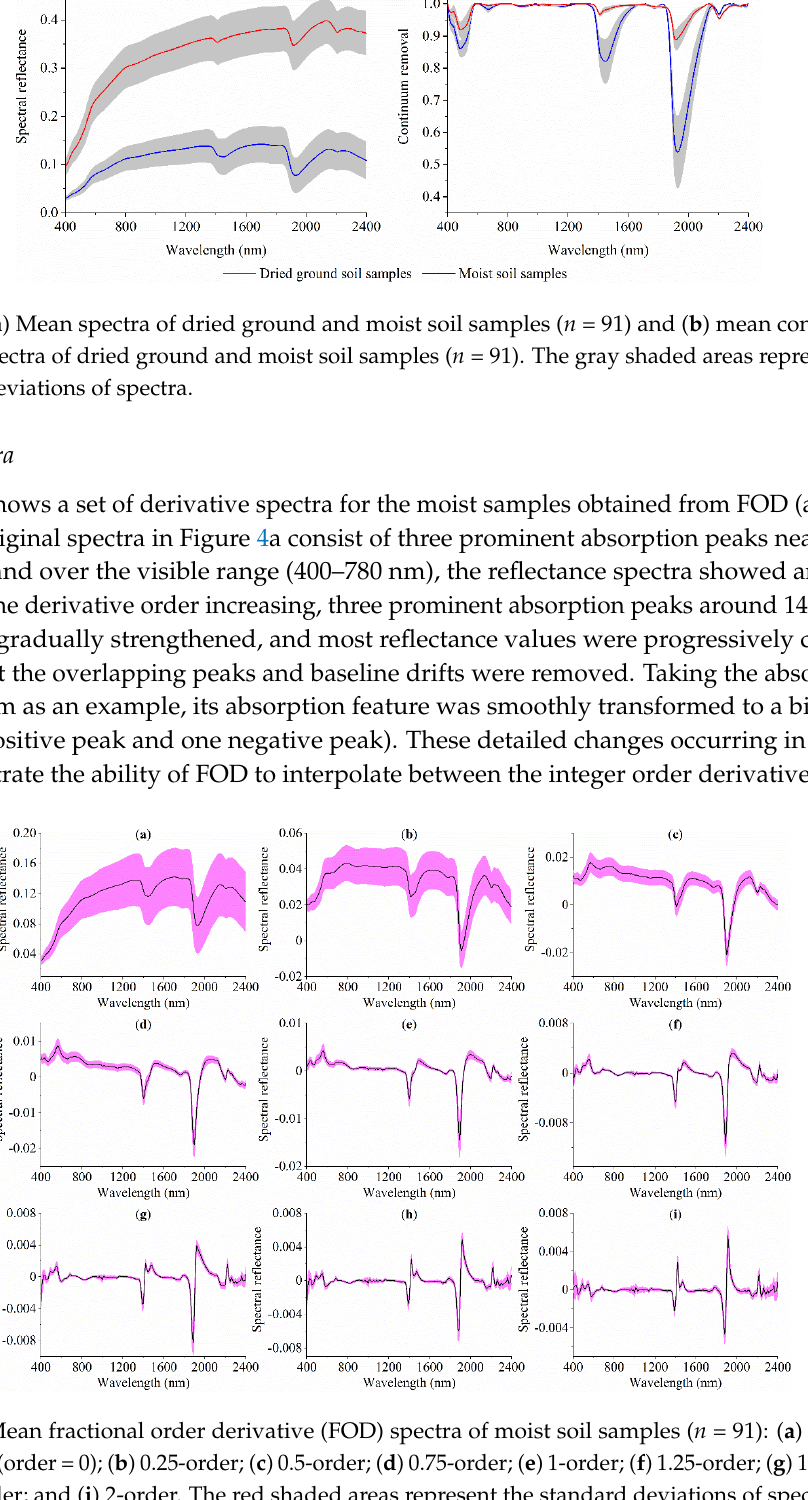
Figure 4. Mean fractional order derivative (FOD) spectra of moist soil samples ( n = 91): ( a ) original reflectance (order = 0); ( b ) 0.25-order; ( c ) 0.5-order; ( d ) 0.75-order; ( e ) 1-order; ( f ) 1.25-order; ( g ) 1.5-order; ( h ) 1.75-order; and ( i ) 2-order. The red shaded areas represent the standard deviations of